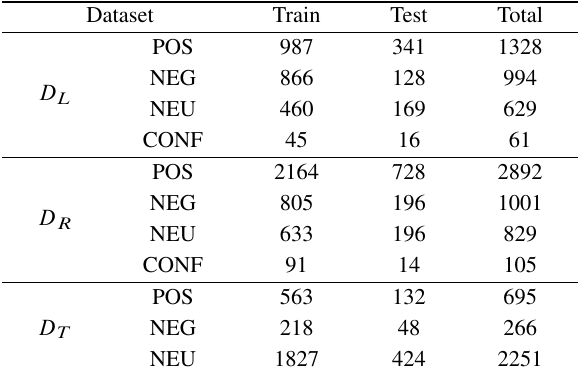
Table 3 Numbers of aspects holding different sentiment polarities in three benchmark